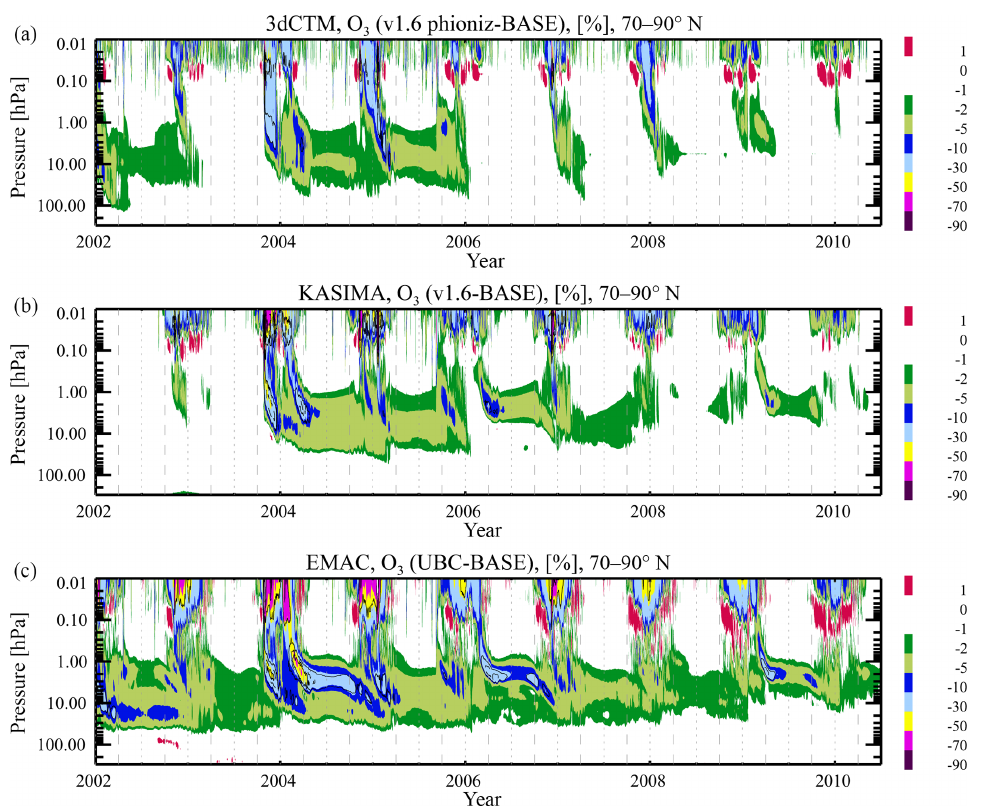
Figure 13. Relative ozone anomalies due to energetic particle precipitation at high northern latitudes (70–90 ◦ N), calculated as the difference of model runs with to without particle impact (%). (a) 3dCTM (v1.6 phioniz – Base), (b) KASIMA (v1.6 – Base), (c) EMAC (UBC – Base). The gray shaded area in the middle figure denotes the time period before the start of the KASIMA model runs. Dashed and dotted vertical gray lines mark zero, one-quarter, one-half, and three-quarters of each year. The thin black contours refer to − 1.5 (solid), − 1 (dashed) and − 0.5 (solid)